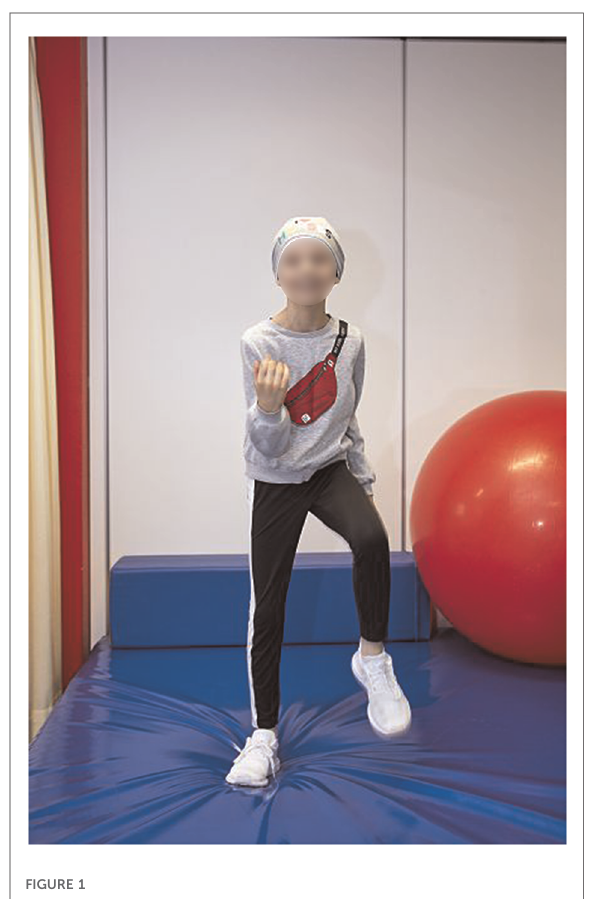
FIGURE 1 Participant from a pediatric exercise oncology research